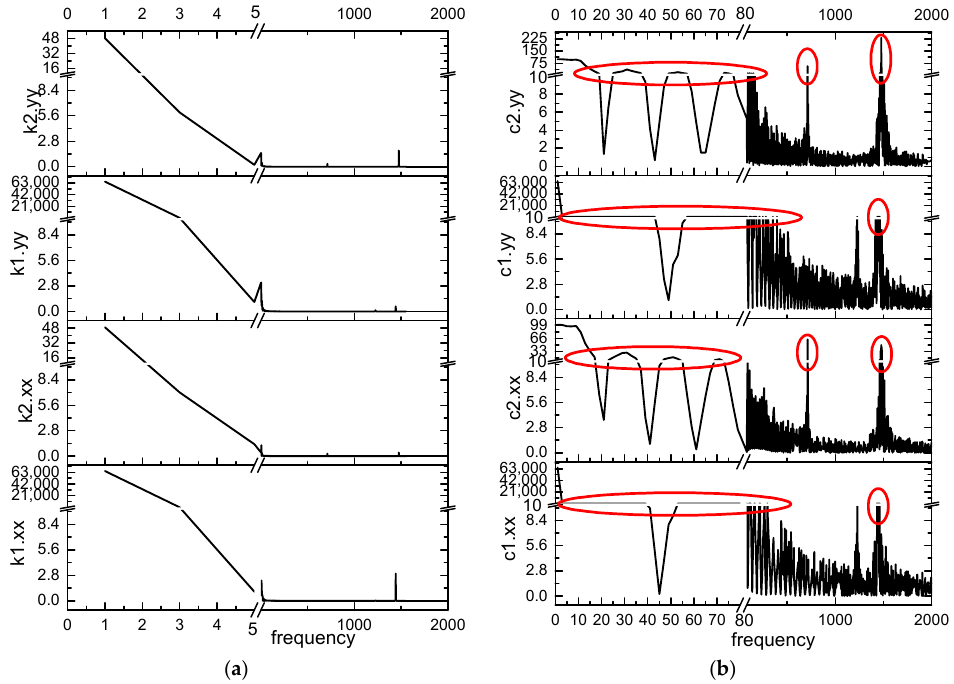
Figure A6. Identified bearing coefficients changing with frequency of g1.1 based on algorithm I considering adjustment point and sensor resolution 1 nm: ( a ) obtained main stiffness coefficients in x and y directions; ( b ) obtained main damping coefficients in x and y directions.